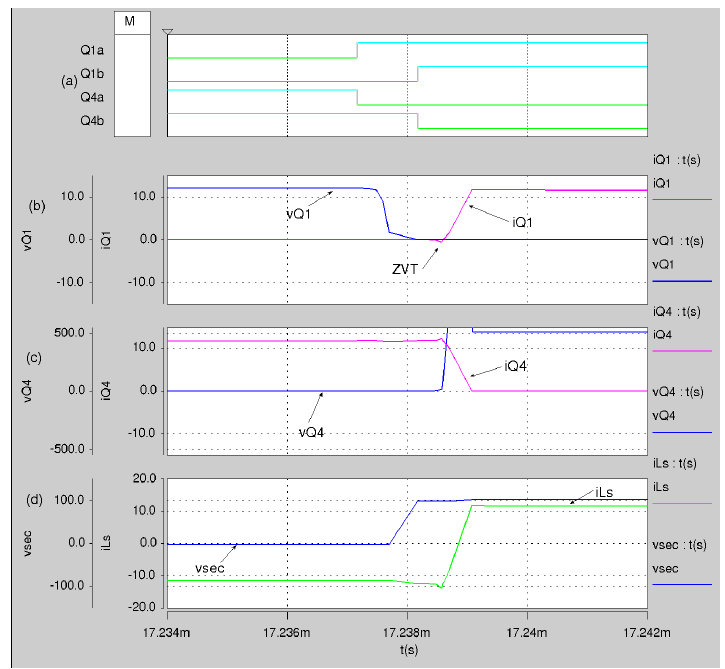
Figure 21. Simulation results to verify ZVT during the switching transition to turn on Q 1 , ( a ) control signals Q 1 a , Q 1 b , Q 4 a , Q 4 b ; ( b ) i Q 1 and v Q 1 ; ( c ) i Q 4 and v Q 4 ; and ( d ) v sec and i Ls . Supply: 127 V, 60 Hz, Output: 100 V, 5 kW.